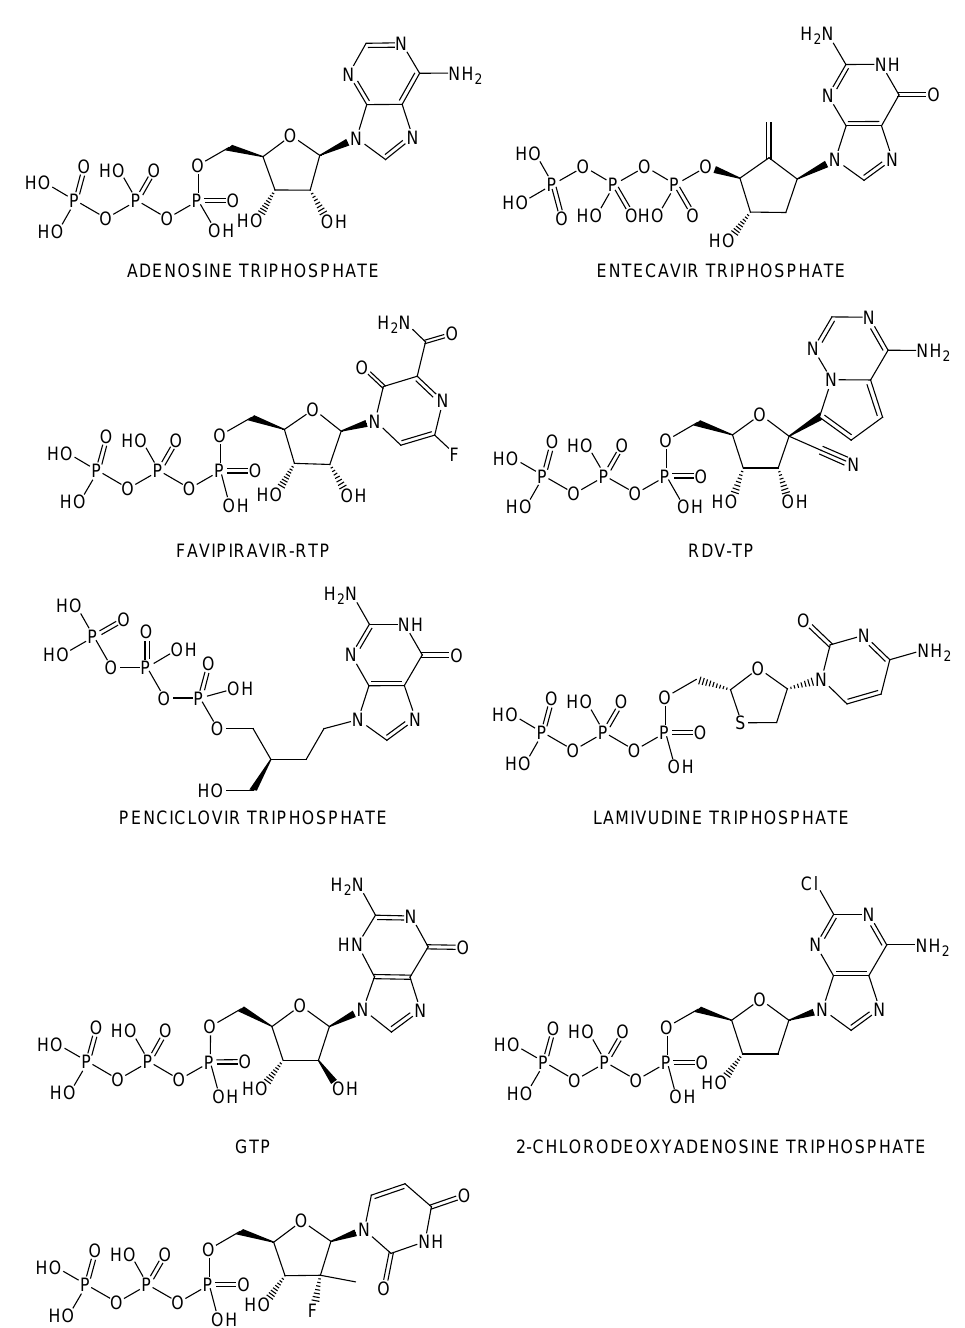
Figure 2. Planar structures of nine nucleoside triphosphate analogs with anti-viral activity obtained from rDock docking simulations.